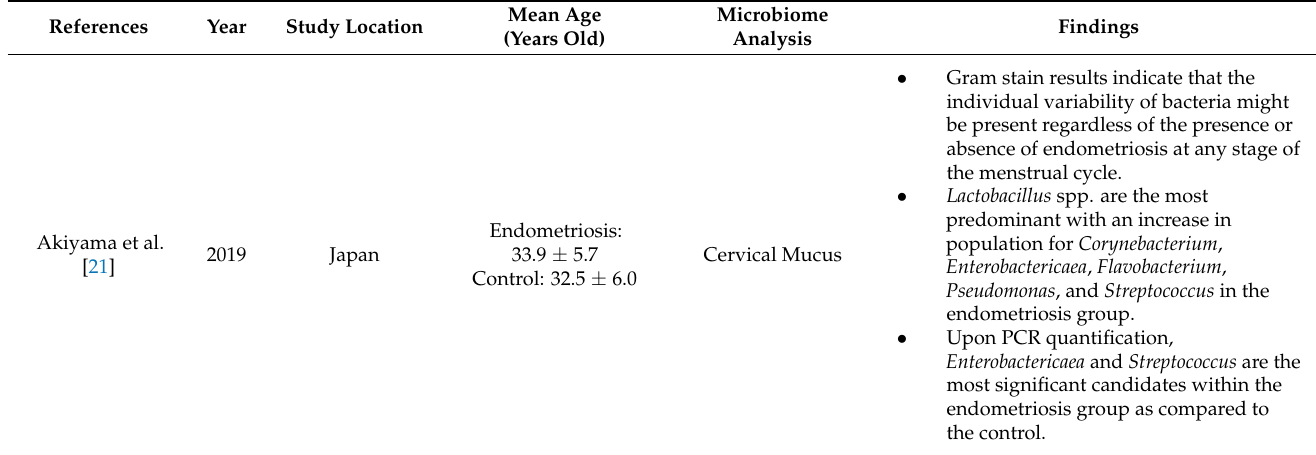
Table 3. Clinical studies reporting changes in the gut, peritoneal and urogenital microbiome (AMEM, adenomyosis-endometriosis; CST, community state type; DIE, Deep Infiltrating Endometriosis; N.A, not available; OCP, oral